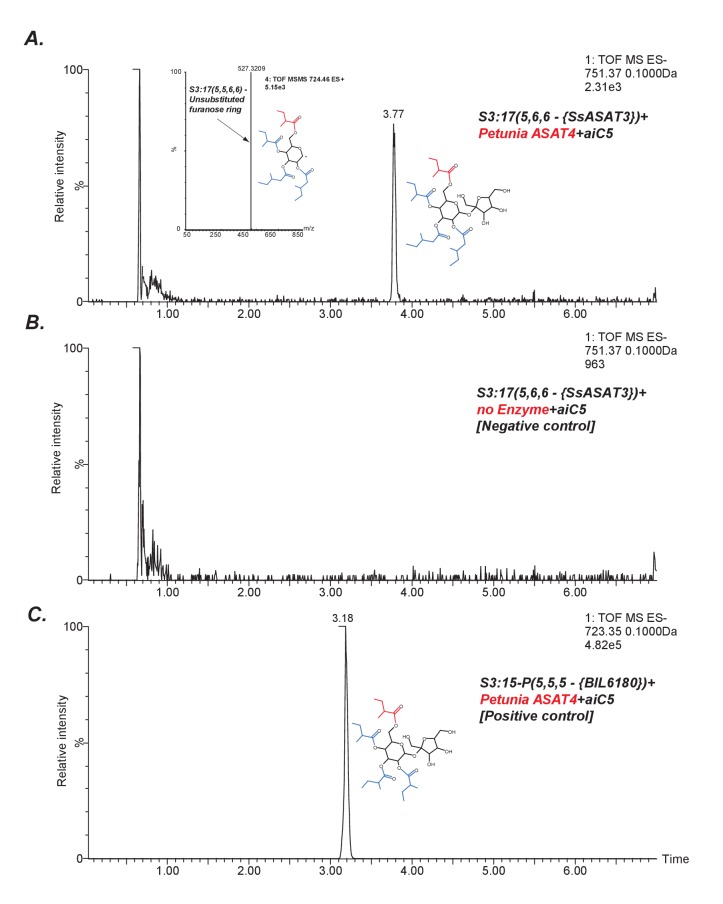
SsASAT3 acylates at the R3 position.An indirect assessment of SsASAT3 positional specificity using Petunia ASAT4, which acylates at the pyranose R6 position (A) The chromatogram shows that Petunia ASAT4, which is known to acylate at the R6 position, can acylate the tri-acylated sugar S3:17(5,6,6) produced by SsASAT3 using the SsASAT2 product S2:10(5,5). The inset shows positive mode data suggesting all four chains are on the same ring. Given R6 is the only free hydroxyl group available on the pyranose ring in S3:17(5,6,6), and since SsASAT1 and SsASAT2 acylate R2 and R4 positions, the only position SsASAT3 can acylate without inhibiting PaASAT4 is R3. (B) Negative control with no enzyme (C) Positive control with S3:15 P(5,5,5) purified from BIL6180, with R2, R3 and R4 positions substituted by C5 chains based on NMR data (unpublished data).